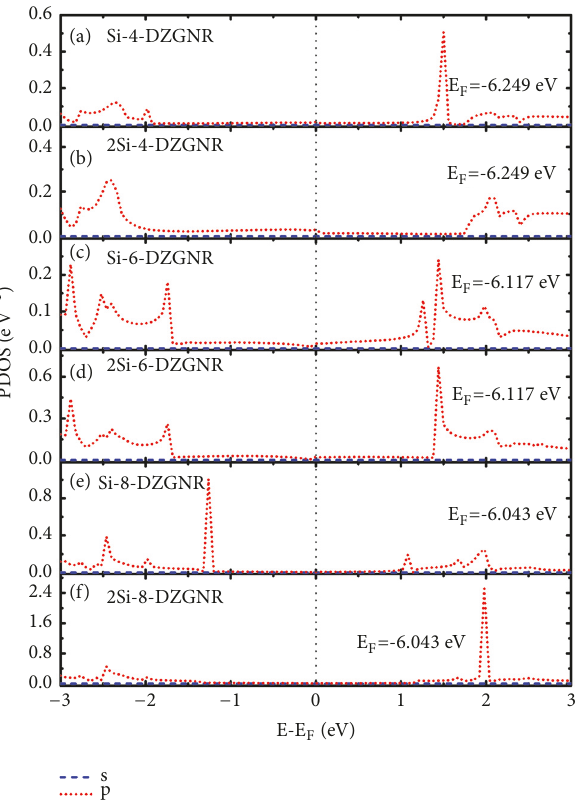
Figure 5: Partial density of states PDOS of Si in two structures: (a) Si-4-DZGNR and (b)